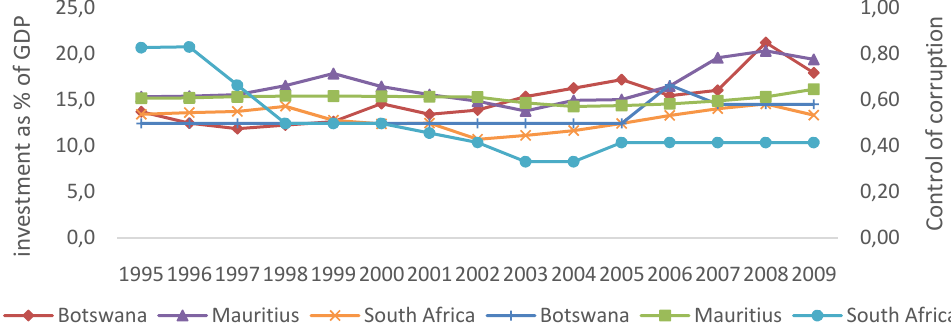
Fig. 5. Control of corruption and investment (gross fixed capital